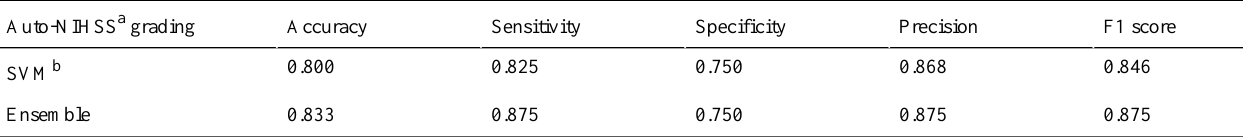
Table 3. Performance of auto-NIHSS grading.